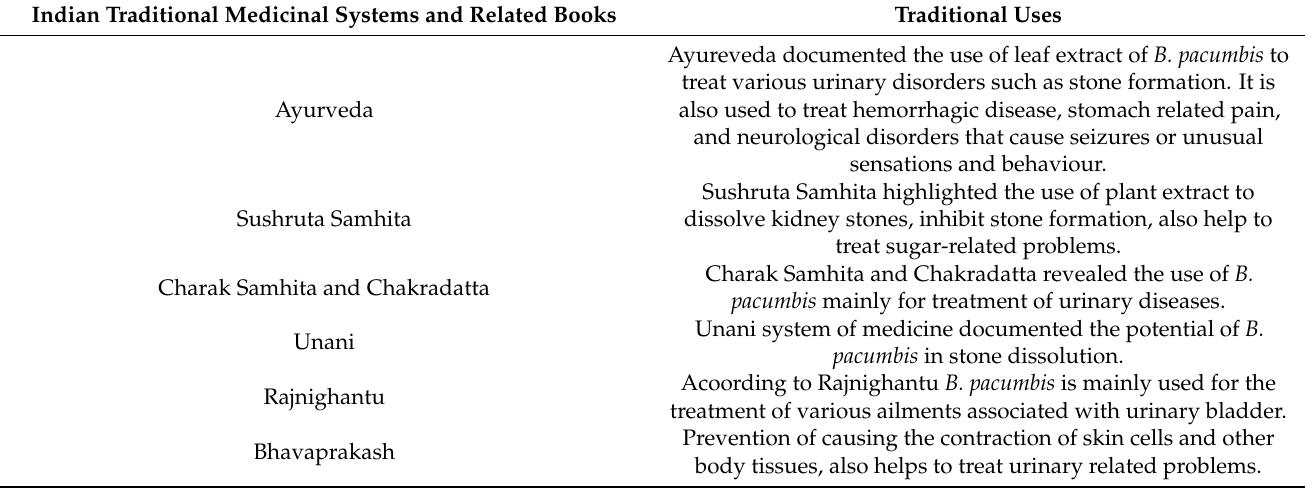
Table 2. Traditional uses of Bergenia pacumbis (Buch.-Ham. ex D.Don) C.Y.Wu & J.T.Pan